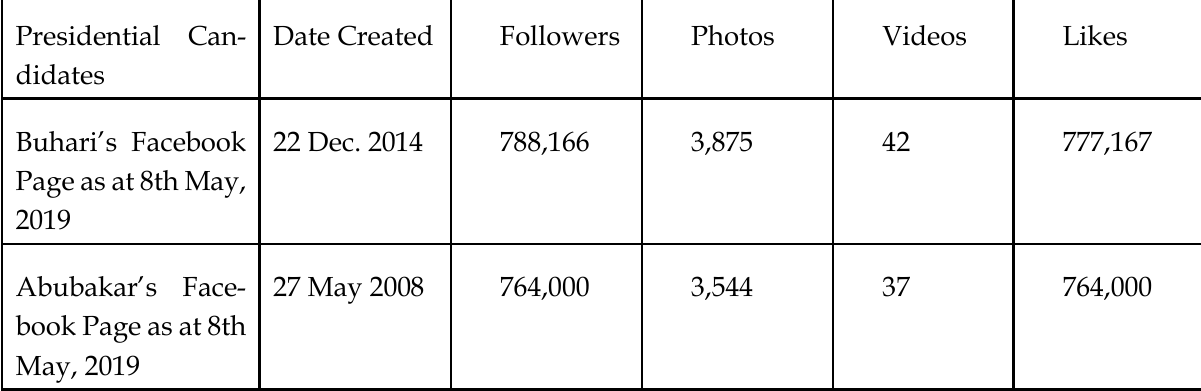
Source: Authors' compilation